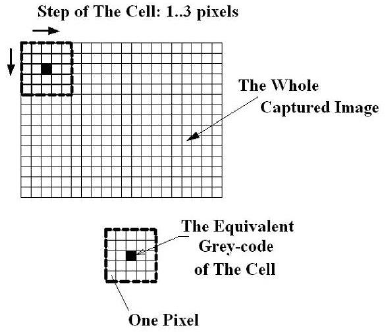
Figure 6. The principle of the image analysis used by VIC-3D [26,27,29].